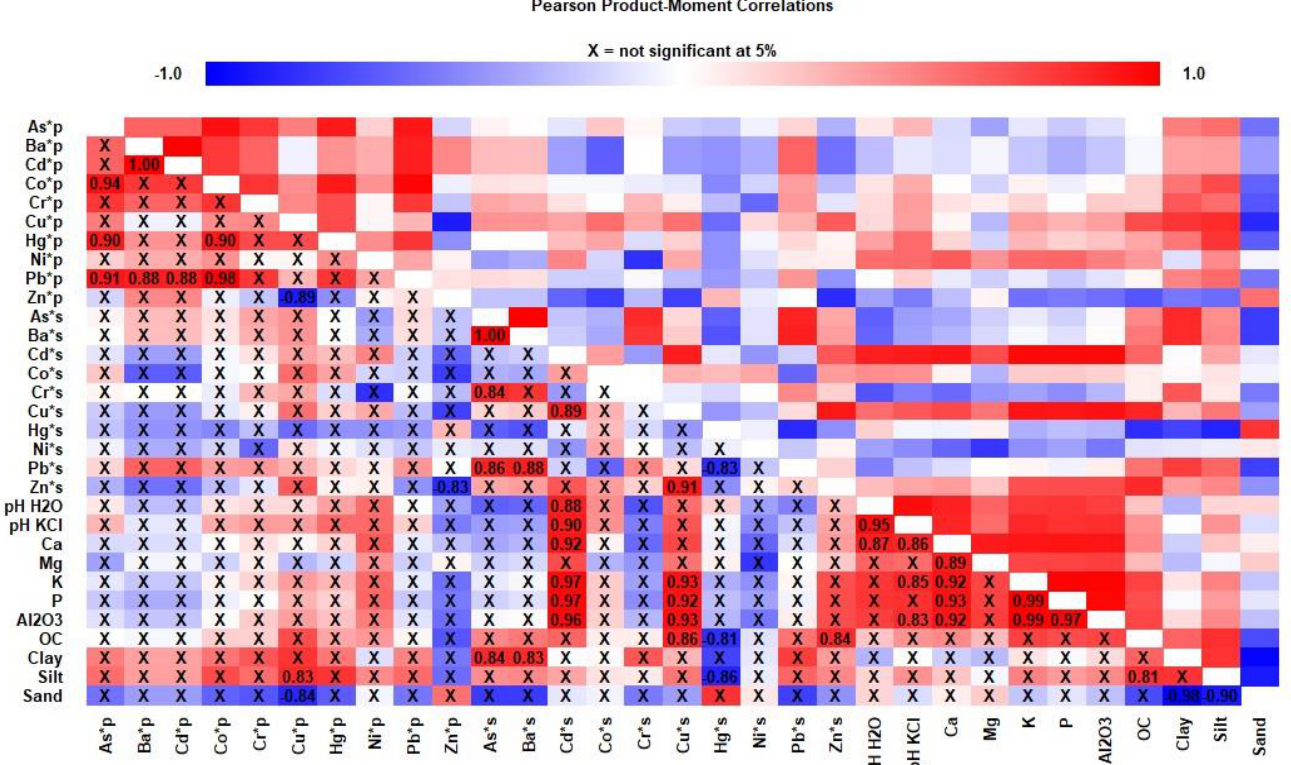
Figure 4. Heatmap of Pearson’s correlation coefficients between soil attributes and potentially toxic elements in soils and plants. * p = plant; * s = soil.